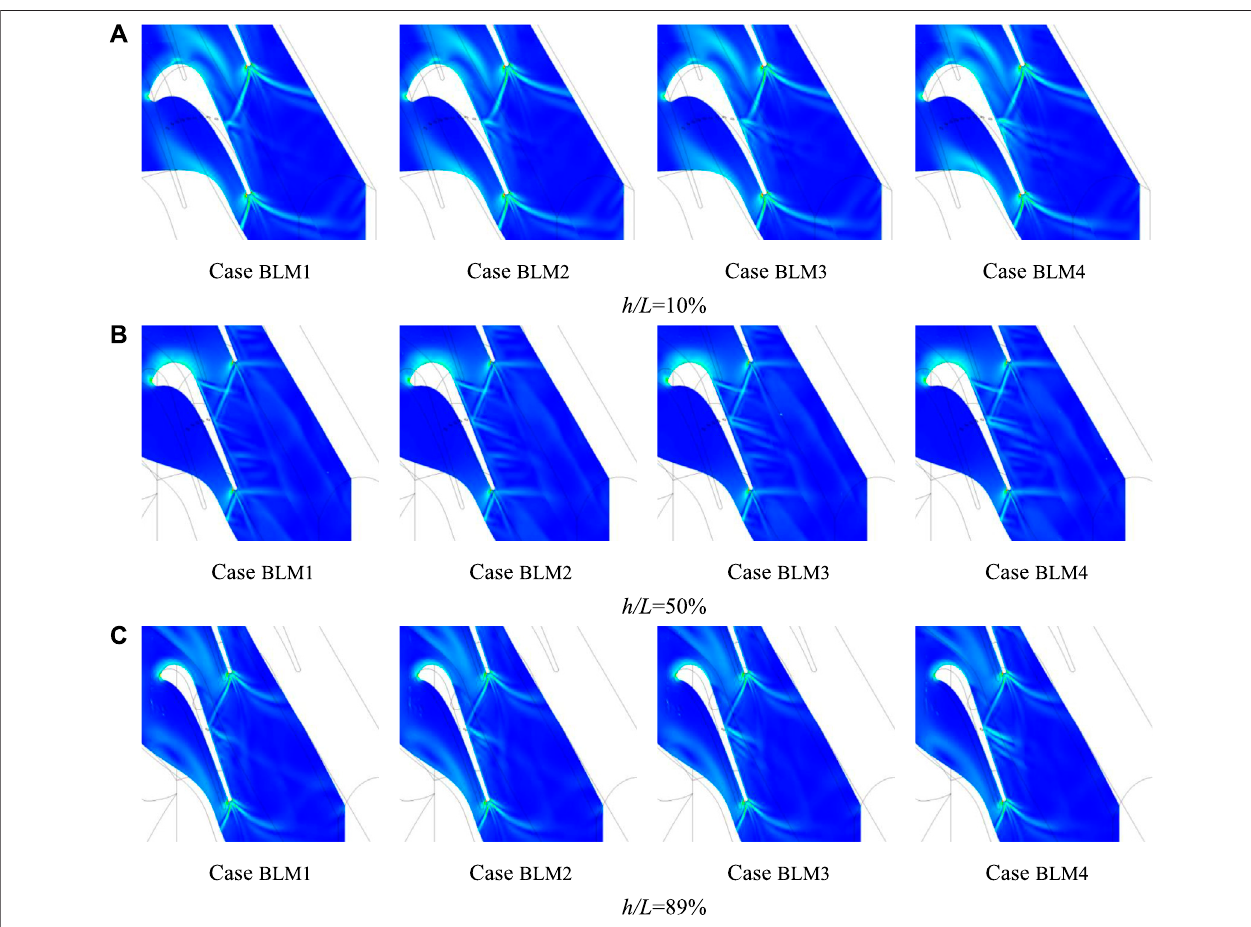
FIGURE 11 | Density gradient distribution in the different height sections of low-degree-of-reaction (DOR) blade airfoil. (A) h/L = 10%, (B) h/L = 50%, and (C) h/L = 89%.